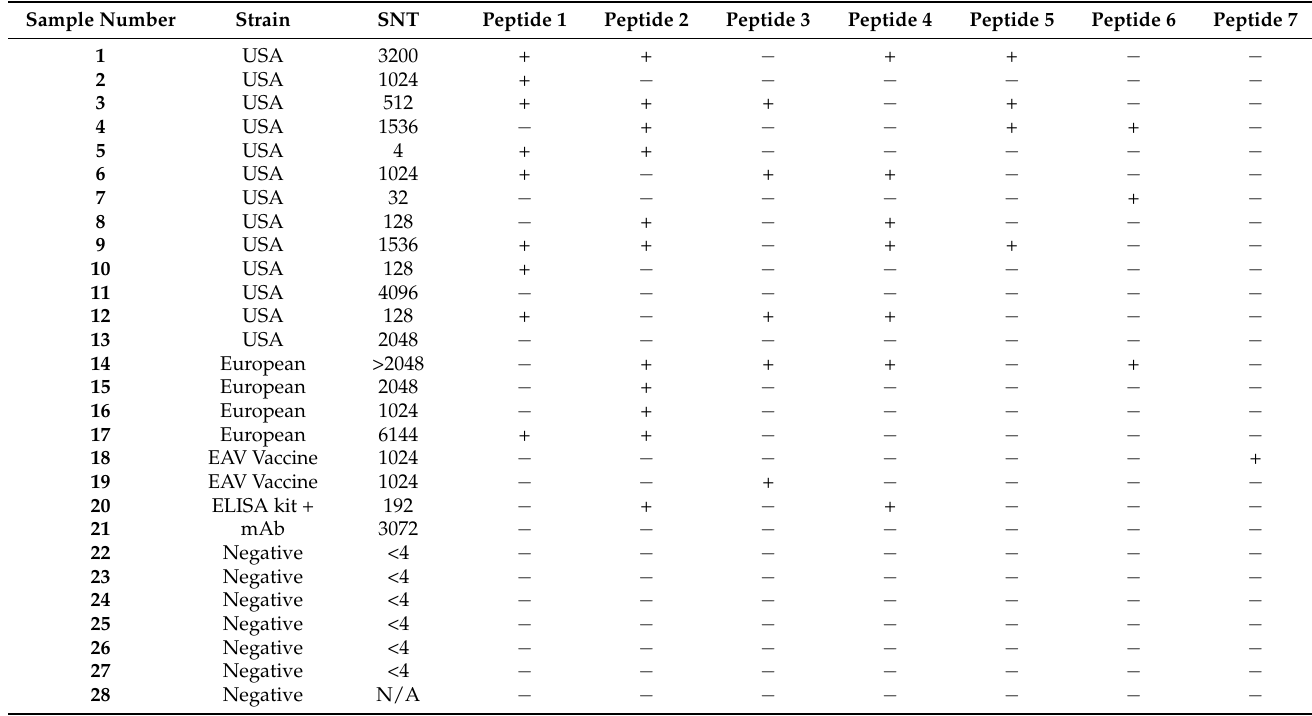
Table 1. Comparison of the serological response of serum from EAV infected horses to seven EAV peptides on the